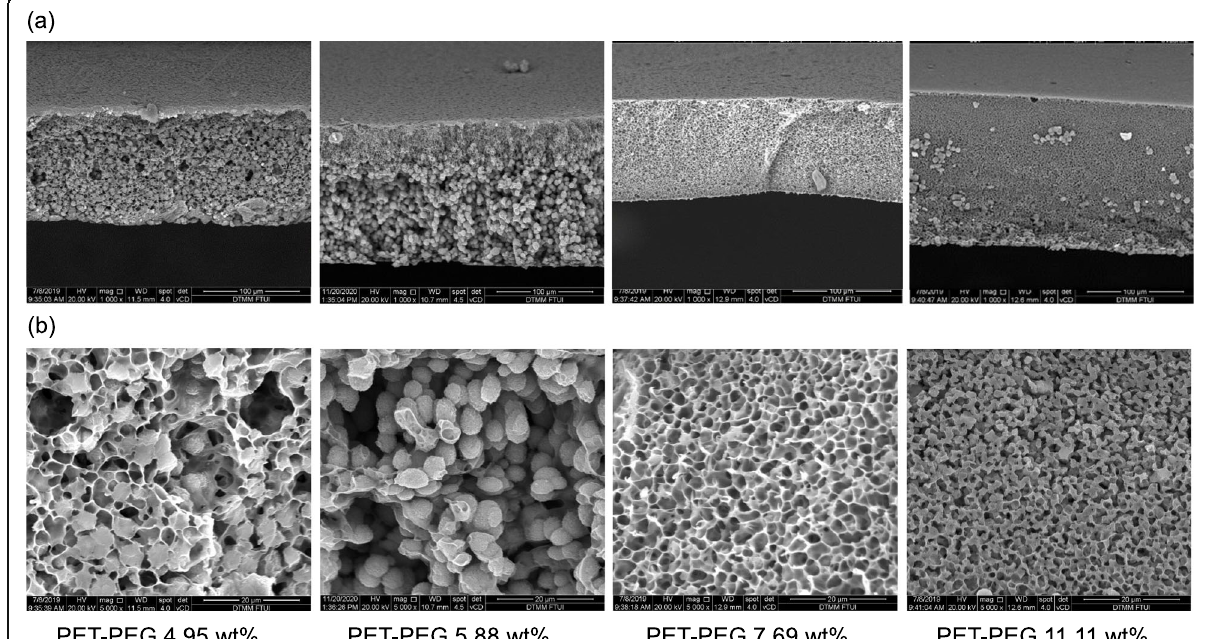
Fig. 4 SEM photographs of the cross section and surface of the PET membranes prepared from PET bottle with different PEG 400 concentrations: ( a ) magnification: 1000 x, ( b ) magnification: 5000